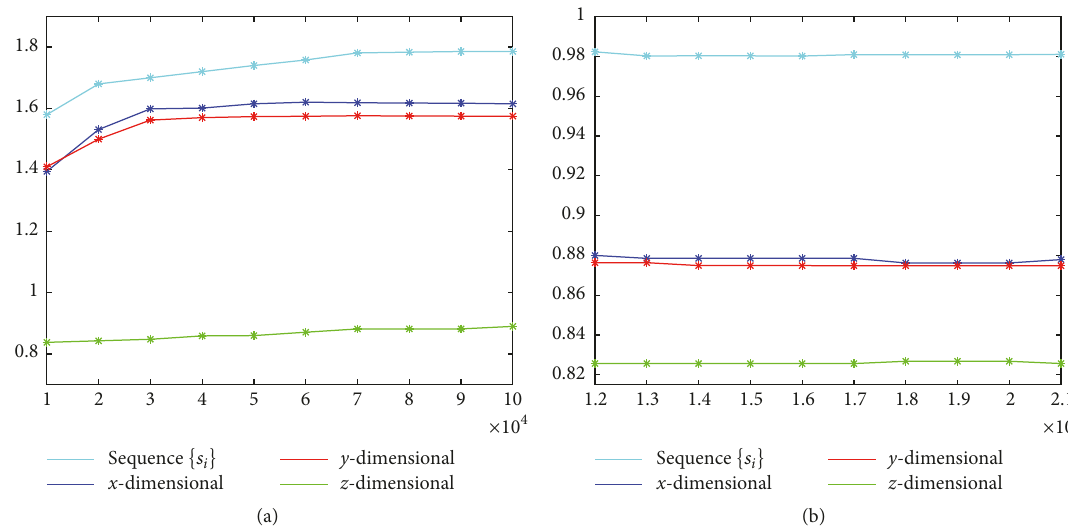
Figure 4: The complexity of sequence {𝑠 𝑖 } and x -dimensional, y -dimensional, and z -dimensional variables of Chen system with a = 35, b = 3, and c = 28 (a) ApEn; (b) PE.